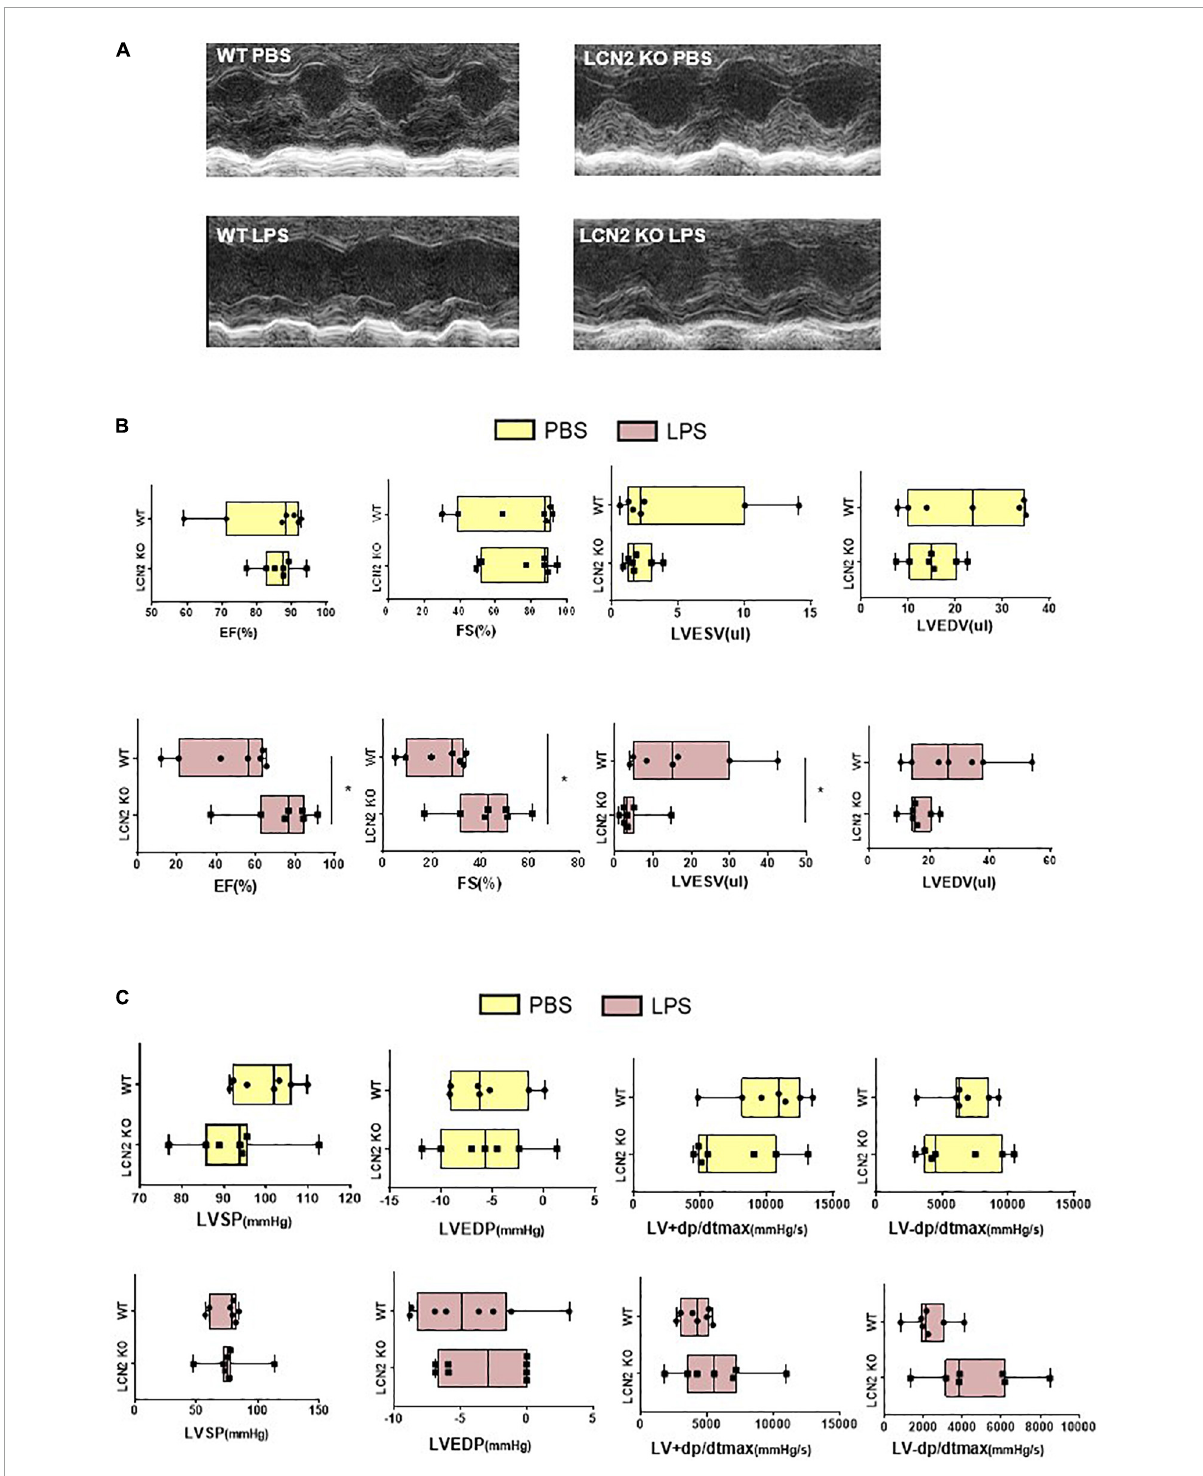
FIGURE2 LCN2 deficiency improved cardiac function in LPS-induced SCD mice. (A,B) Echocardiography was performed 12 h after intraperitoneal injection of either PBS or LPS (25 mg/kg) to evaluate EF, FS, LVEDV, and LVESV in LCN2 KO mice and their WT littermates ( n = 7 in each group). (C) Invasive hemodynamics was monitored 12 h after intraperitoneal injection with either PBS or LPS (25 mg/kg) in LCN2 KO mice and their WT littermates ( n = 7 in each group). Measurement data are presented as median with 95% CI. * p <